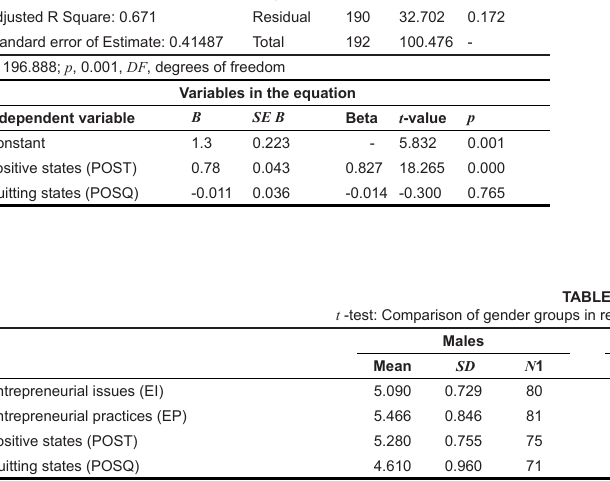
TABLE 10 analysis of variance DF Sum of Mean squares square